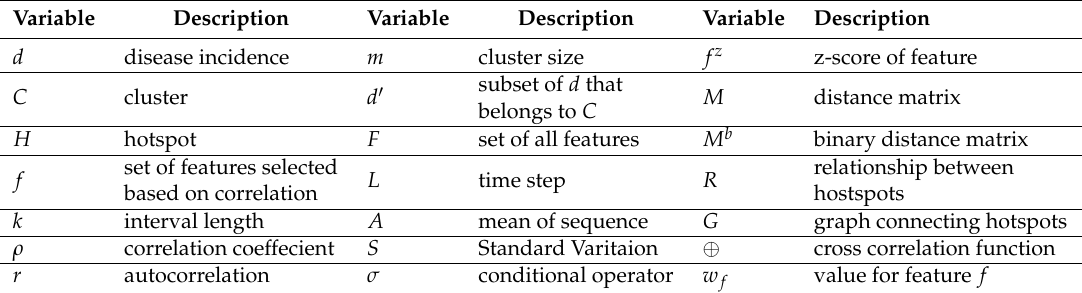
Figure 2. The conceptual model for disease management involving complex interdependent driving factors integrated over spatial and temporal regions. At Layer 1, the data were divided into a series of time slices and each disease incidence is represented in space by (x,y) in corresponding time slice. Layer 2 represents a single time slice, where additional features of interest are added in a given time frame for particular hotspots. Layer 3 presents the trend of hotspots in each hotspot location over all time slices or identification of similar and different hotspots based on all space and time data analysis. Table 1. Variables and their descriptions defined in the mathematical model for disease